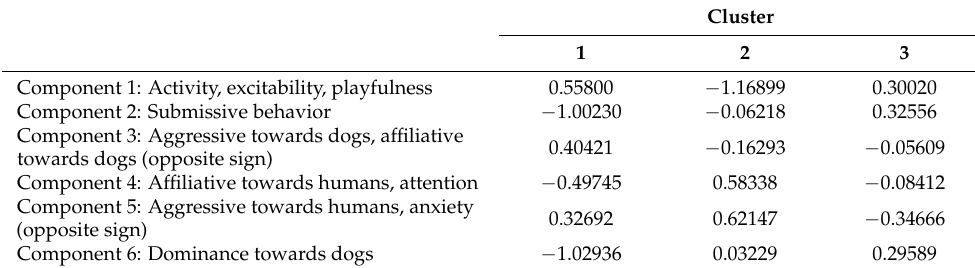
Table 4. Results from the Cluster